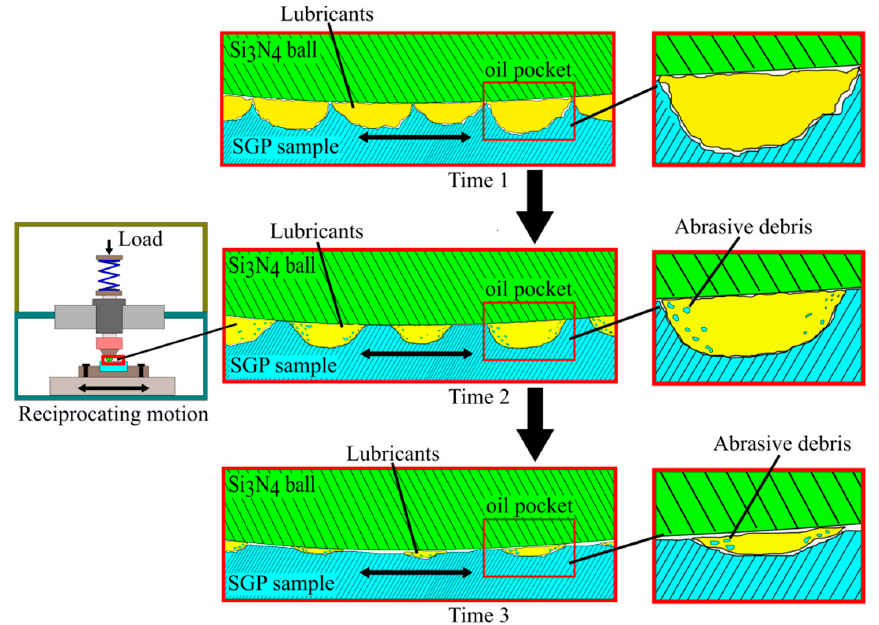
Figure 13. Two-dimensional illustration of the microscope oil pocket.